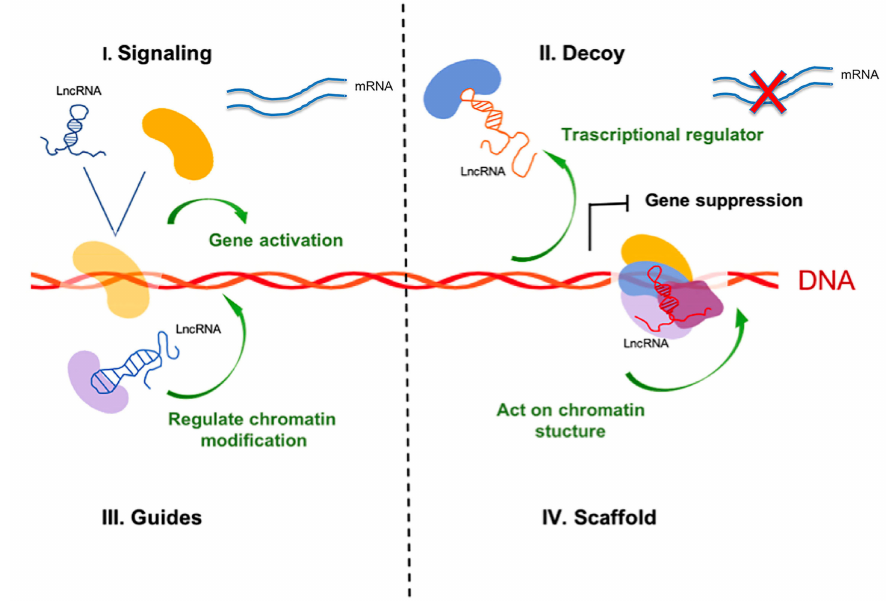
Figure 1. Classification of lncRNA based on the mechanism of action. LncRNA-mediated transcriptiona lregulation through four archetypes based on their molecular mechanism. LncRNAs that belong to the “signaling archetype”: they act as molecular signal activating or silencing genes depending on the stimulus ( I ); “decoy archetype”: the lncRNAs act asdecoys that bind to and interfere with another sequence or structure for binding, considered like negative regulators ( II ); “guide archetype”: the lncRNAs bind to specific proteins and transport them to the specific target sequence. The interaction may be direct (between lncRNA-protein complex and the DNA) or indirect (between lncRNA-protein and protein-DNA complexes) ( III ); “sca ff old archetype”: lncRNAs act by bringing proteins into a complex or in spatial proximity to facilitate the interaction ( IV